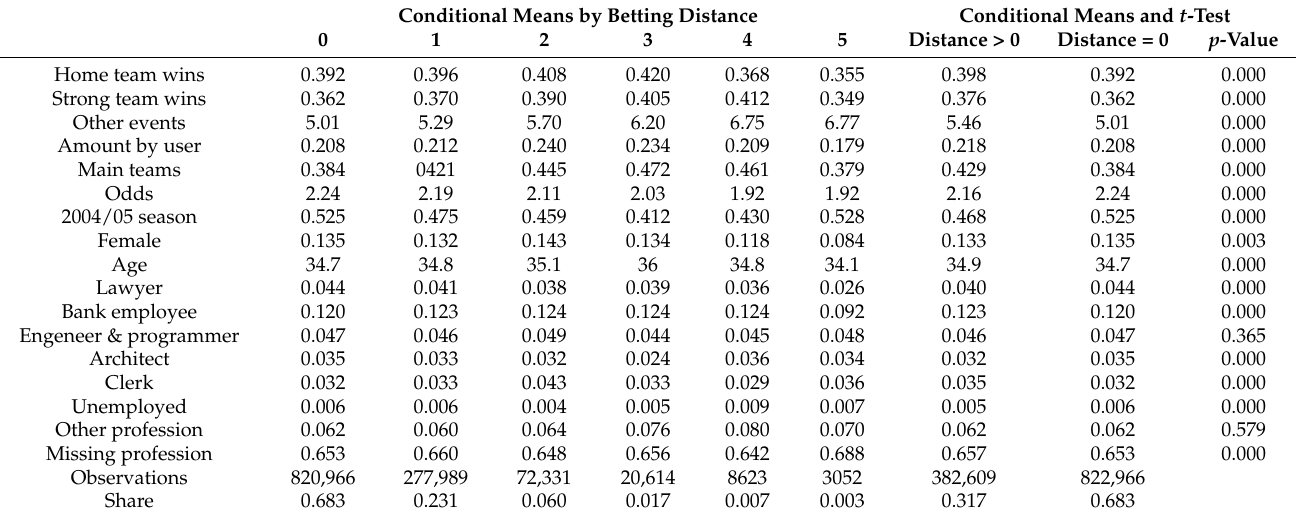
Table 2. Conditional means by betting distance. Conditional Means by Betting